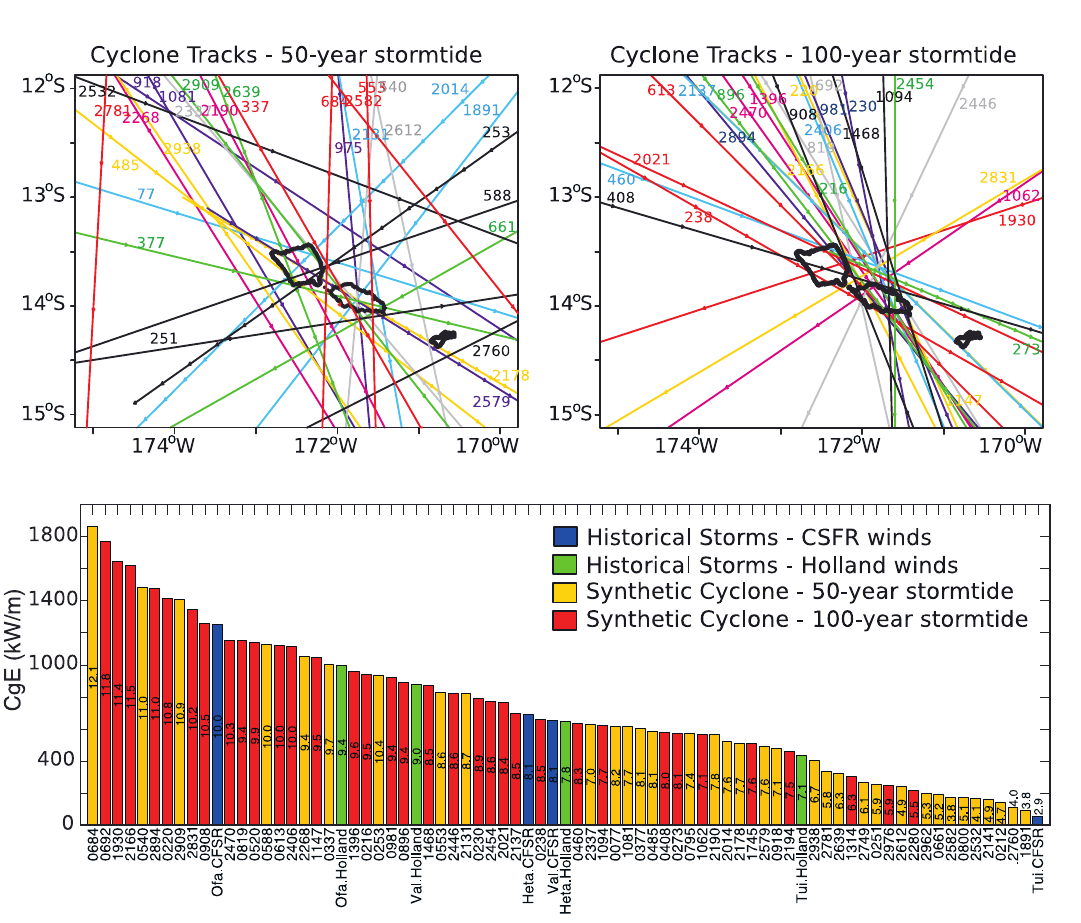
Figure 4. Upper panels: synthetic cyclone tracks used in this study: selected 50-year RI ensemble ( left ) and 100-year ensemble tracks ( right ). Lower panel: maximum wave energy flux ( C g E ) calculated by the SWAN model at a point just north of the Apia Model’s boundary for each of the events modeled in this study; labels on the bars indicate corresponding significant wave